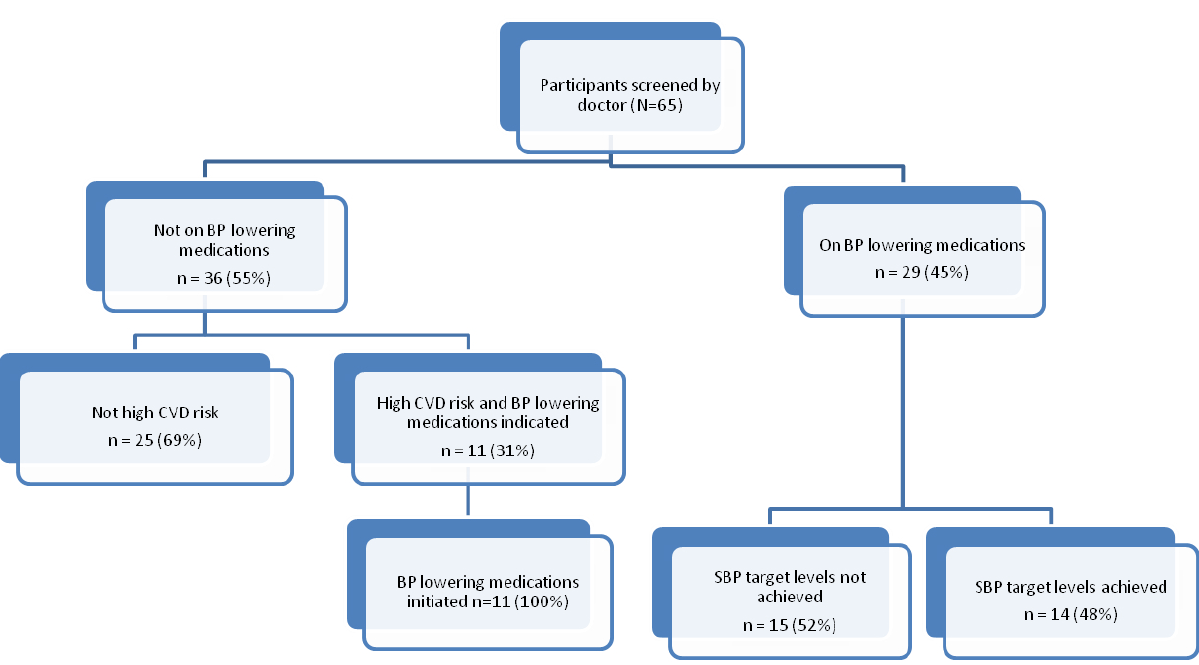
Figure 4. Blood pressure management in participants screened by the physician